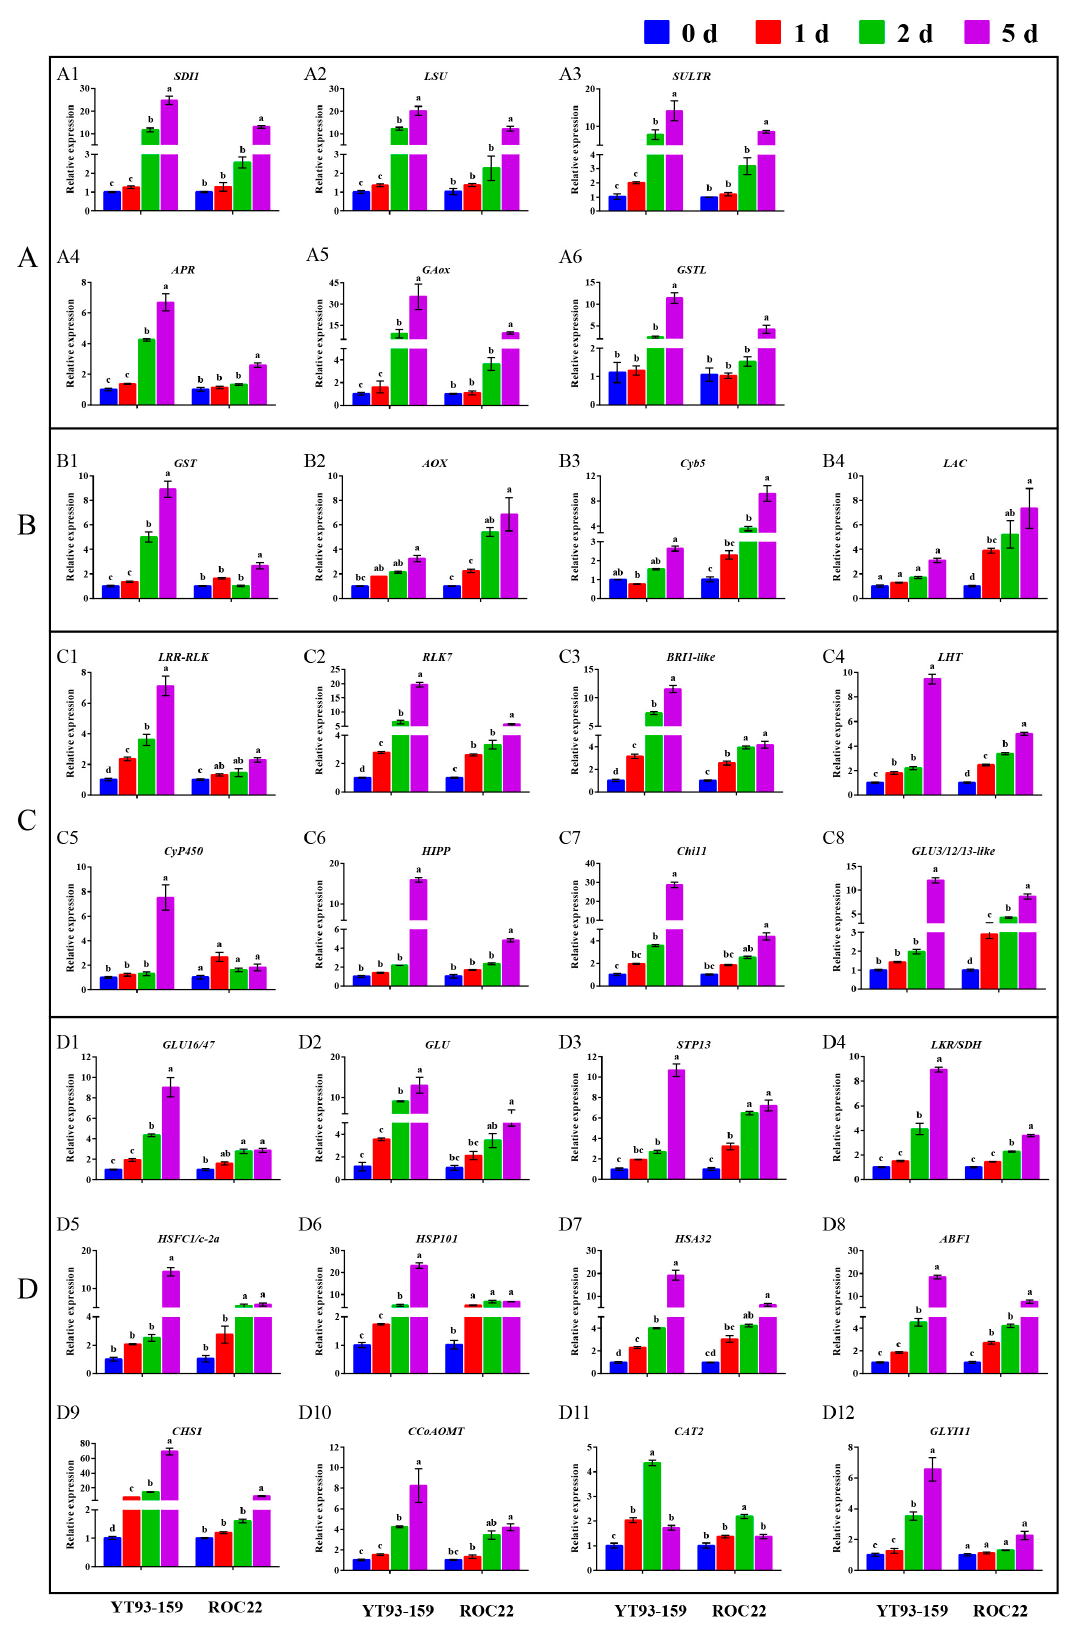
Figure 9. Relative expression of 30 hub genes in sugarcane after inoculation with S. scitamineum by RT-qPCR. ( A ) Skyblue module. ( B ) Salmon module. ( C ) Darkorange module. ( D ) Grey60 module. 0 d (blue), 1 d (red), 2 d (green), and 5 d (purple) for YT93-159 and ROC22 at 0 d, 1 d, 2 d, and 5 d post- S. scitamineum inoculation, respectively. All data points are mean ± standard error ( n = 3). Bars superscripted by different lowercase letters indicate significant differences at 5% level ( p ≤ 0.05). A1,